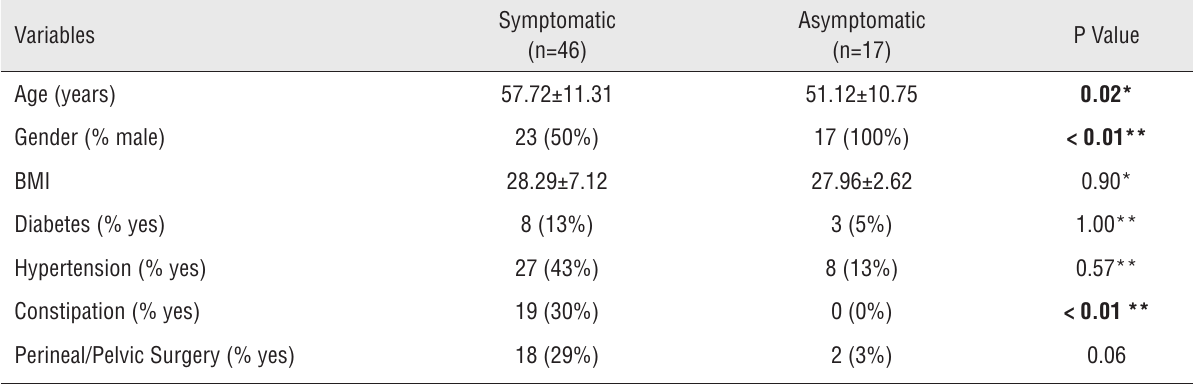
Table 1 - Clinical and sociodemographic data of the patients enrolled in the study.